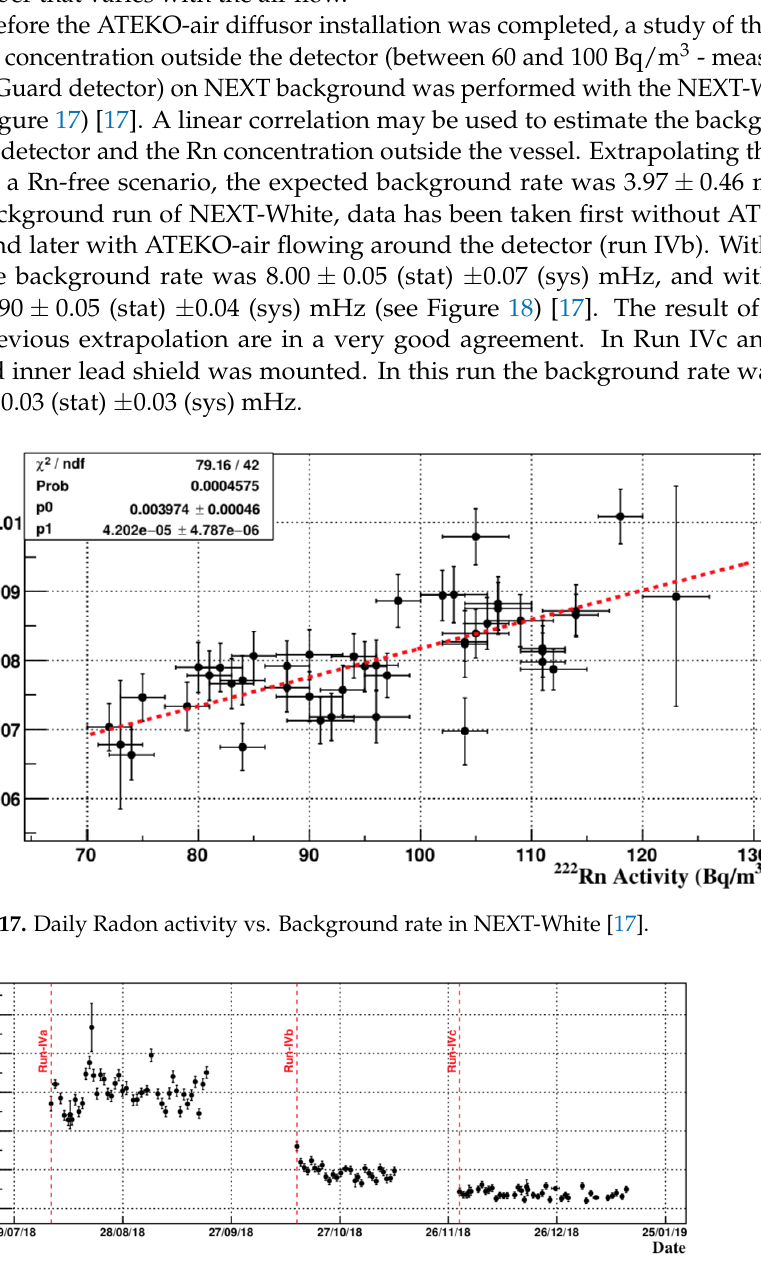
Figure 18. Evolution of the total background in NEXT-White detector. The vertical dashed red lines indicate the beginning of each run